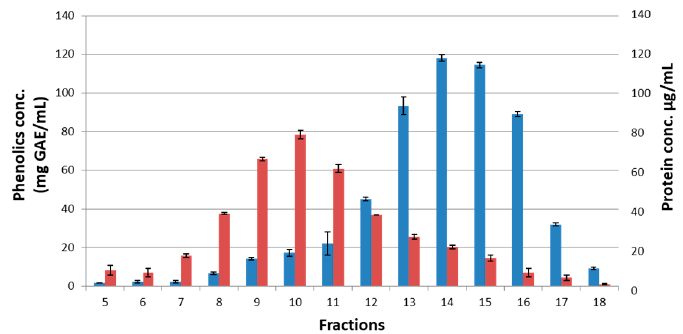
Figure 4 . The total phenolic and protein contents in fractions obtained from size-exclusion chromatography of honey H177 on Sepharose 4B.